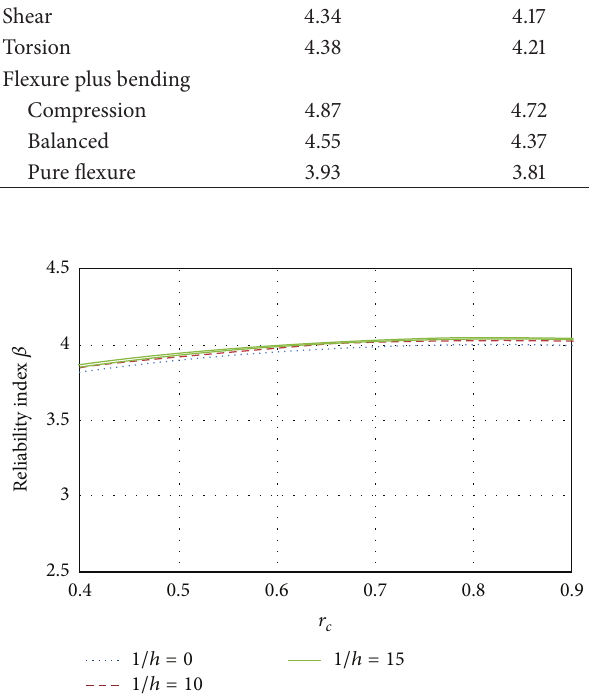
Figure 13: Influence of the slenderness; 𝑒 = ∞ .